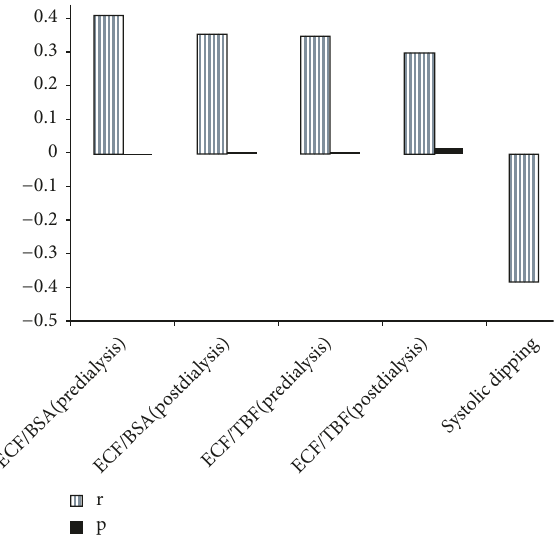
Figure 1: The correlation between LVMI and bioimpedance param- eters and systolic